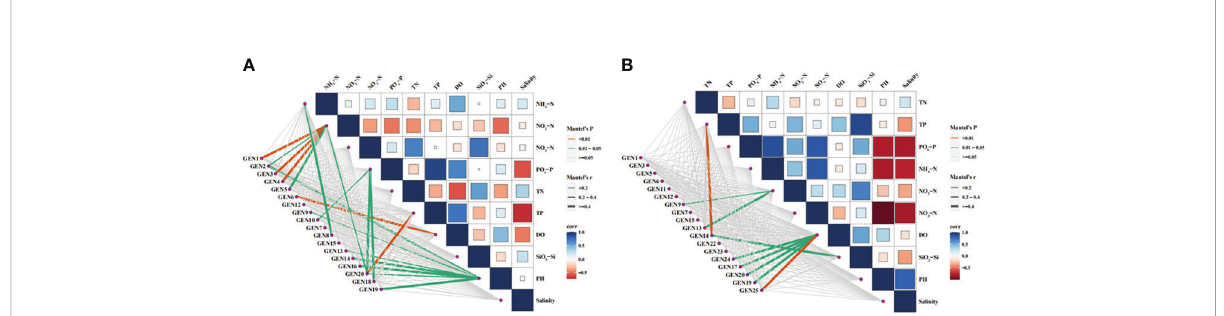
FIGURE 7 Relationships between environmental factors and the abundances of dominant phytoplankton species based on phylogenetic molecular ecological network analysis. Abbreviations are as follows: GEN1: Bathycoccus prasinos , GEN2: Ostreococcus sp., GEN3 Micromonas pusilla , GEN4: Micromonas sp., GEN5: Pyramimonas australis , GEN6: Nannochloris sp., GEN7: Plagioselmis prolonga , GEN8: Teleaulax amphioxeia , GEN9: Cryptomonadales sp., GEN10: Storeatula major , GEN11: Teleaulax minuta , GEN12: Geminigera cryophila , GEN13: Heterocapsa sp., GEN14: unclassi fi ed dino fl agellate, GEN15: Gymnodinium sp.,GEN16: Skeletonema marinoi , GEN17: Skeletonema costatum , GEN18: Thalassiosira rotula , GEN19: Thalassiosira tenera GEN20: Minidiscus comicus , GEN21: Cerataulina pelagica , GEN22: Chaetoceros tenuissimus , GEN23: Chaetocerus sp., GEN24: Cyclotella choctawhatcheeana , and GEN 25: unclassi fi ed dino fl